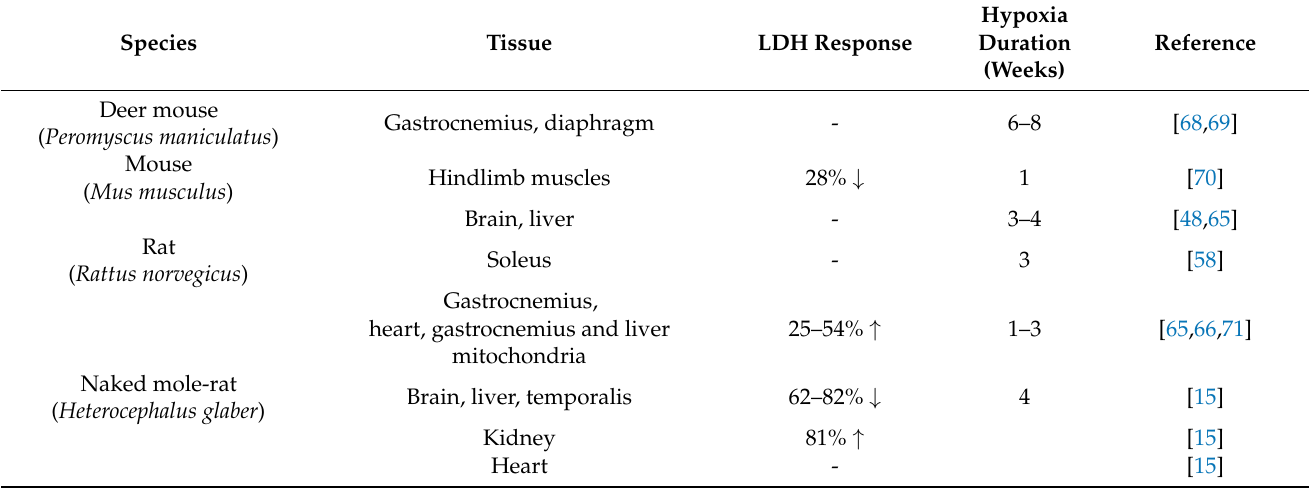
Table 5. Effects of chronic hypoxia (minimum 1 week) on the maximal activity of lactate dehydrogenase (LDH) in various